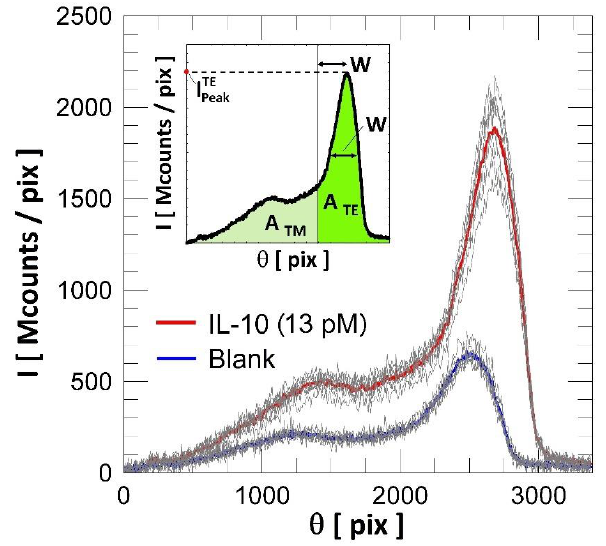
Figure 2. Background subtracted average fluorescence spectra for a blank (blue curve) and an IL-10 (red curve) sample. The curves were obtained by averaging eight spots from central regions of different biochips exposed to such solutions.